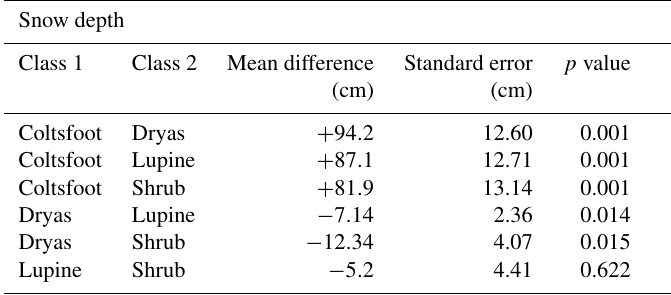
Table 4. Post hoc analysis with Games–Howell for snow depth in vegetation classes (non-parametric test). Each row presents the variance between snow depth means from two different groups. All vegetation groups were tested on each other. Snow